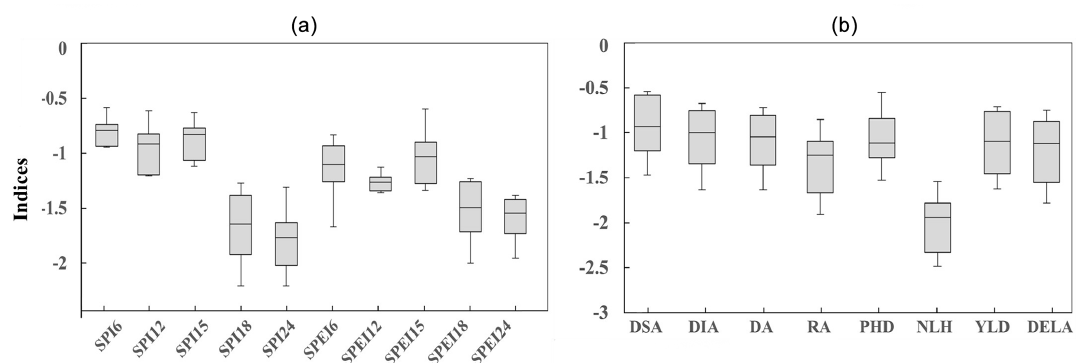
Figure 6. Box plots showing the splitting value (i.e. the thresholds of impacts) in the random forest construction across all impact types for each index (a) , and across all indices for each impact type (b) in Liaoning